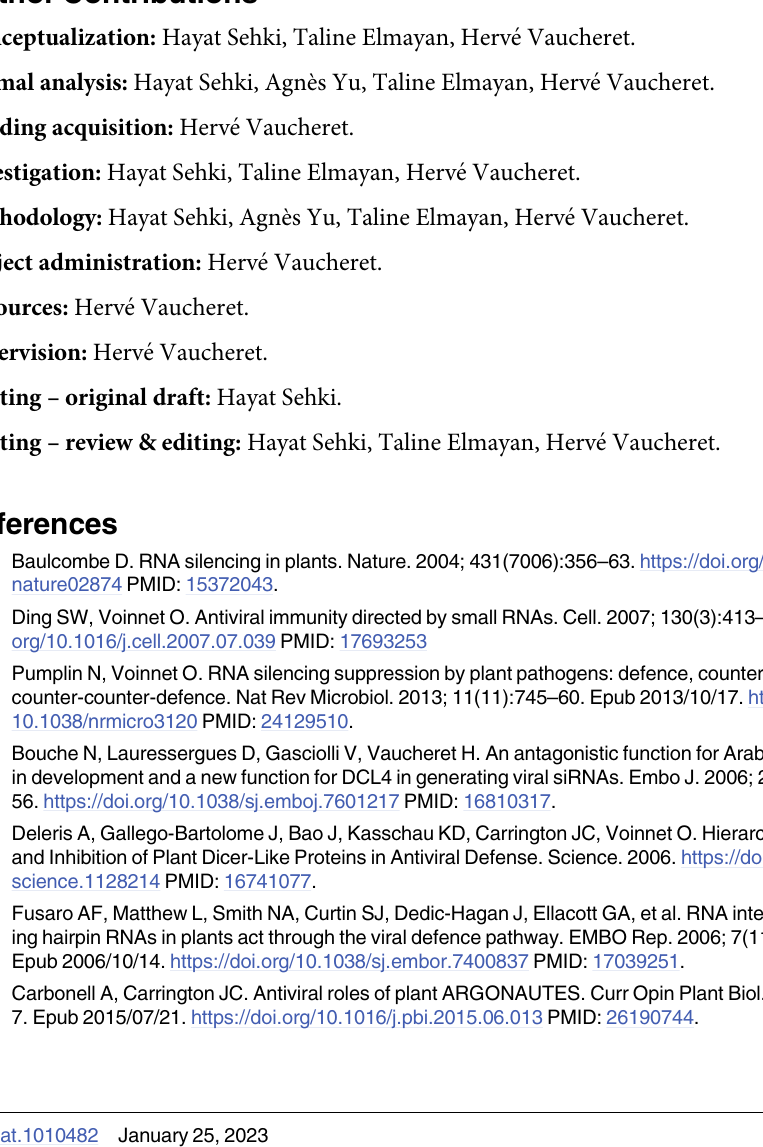
S1 Table. Primers used for genotyping of newly described mutant, probes synthesis and hybridization. S2 Table. qRT-PCR